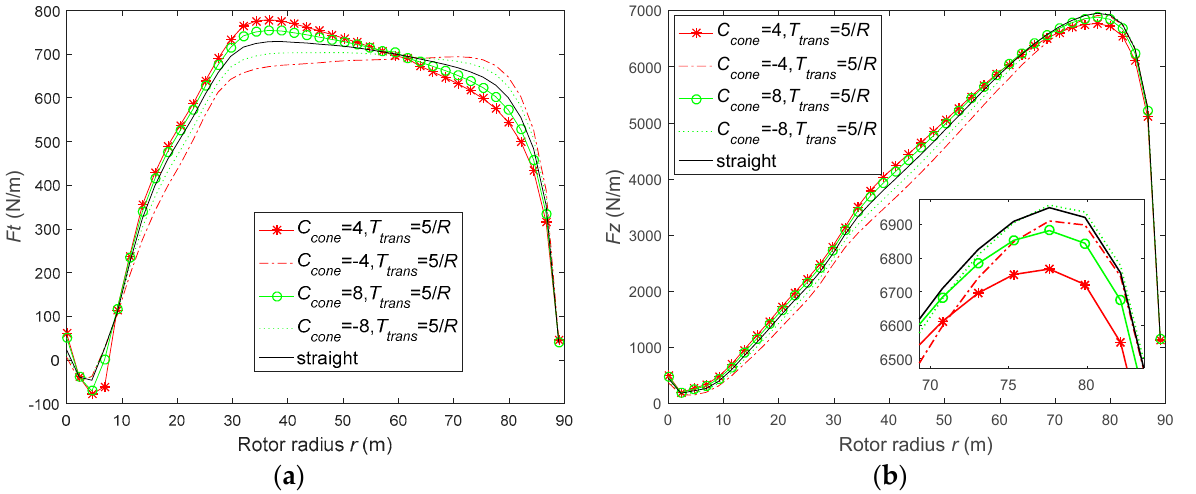
Figure 5. Force distributions along radial direction: ( a ) tangential force; ( b ) axial force.